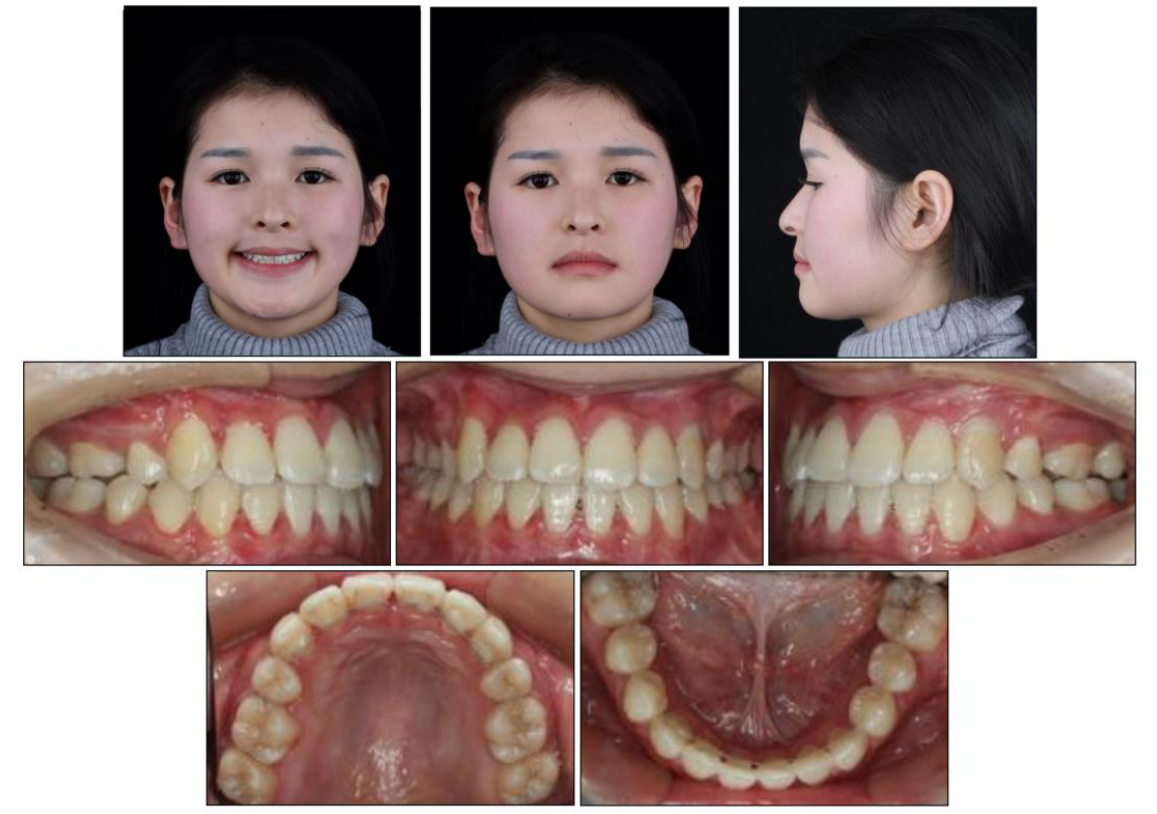
Figure 7. Posttreatment facial and intraoral photographs.